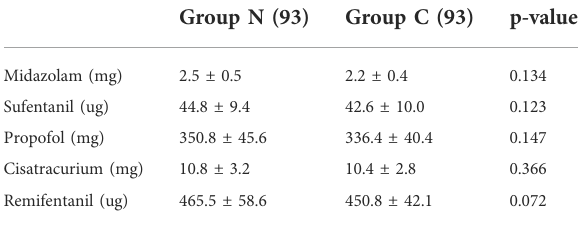
TABLE 2 Comparison of anesthetic dosages between the two